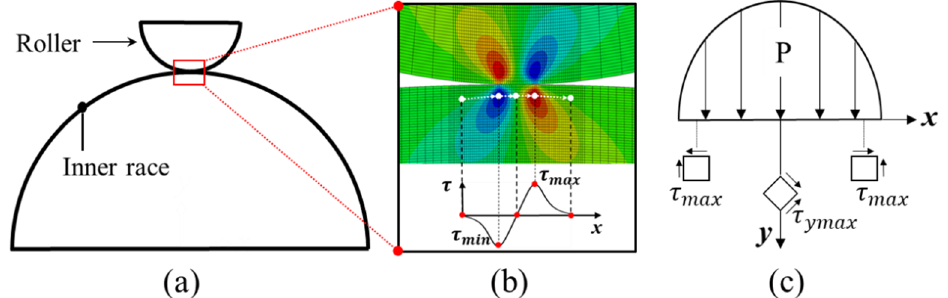
Figure 2. Shear stress distribution in the contact area between roller and raceway. ( a ) Two-dimensional model of roller and raceway. ( b ) Nephogram of shear stress distribution in the contact area. ( c ) Maximum orthogonal shear stress and maximum shear stress on the subsurface under contact load.